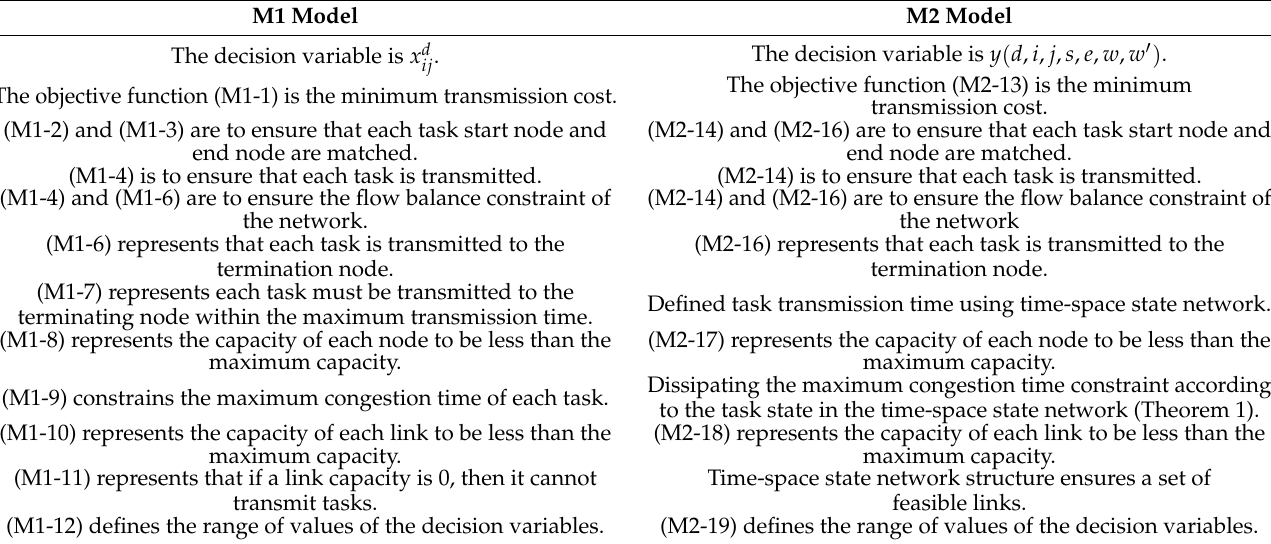
Table 4. Comparison of M1 model and M2 model